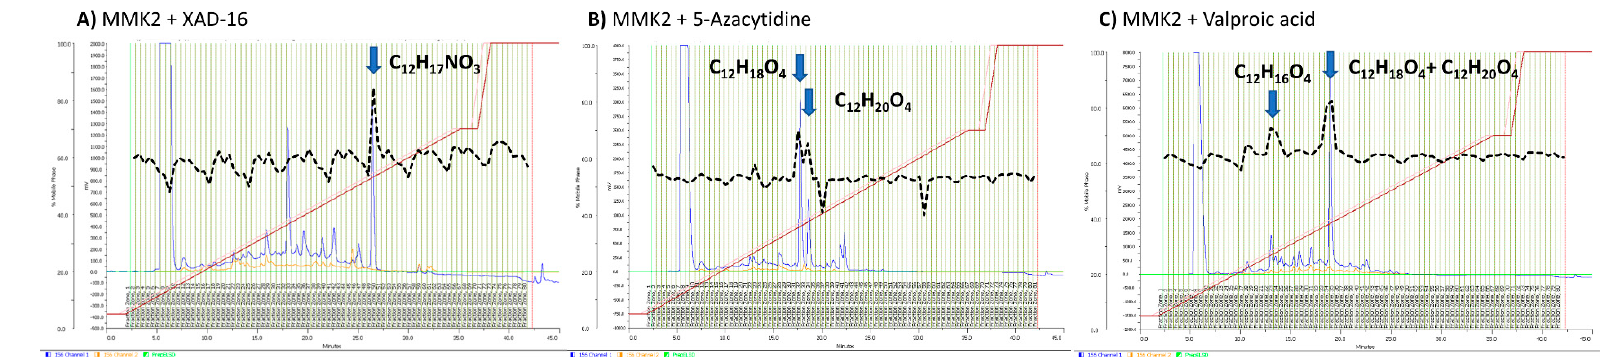
Figure 5. Antitumoural activity profiles (HepG2, MCF-7 and Miacapa-2) marked as a black dashed line overlapping the semi-preparative HPLC fractions for each active fermentation conditions of the strain CF-090383 in MMK2 medium: ( A ) supplemented with XAD-16 resin; ( B ) supplemented with 5-azacytidine, and ( C ) supplemented with valproic acid. Predicted molecular formulas by HR-MS for the main component of each active fraction are indicated in bold.